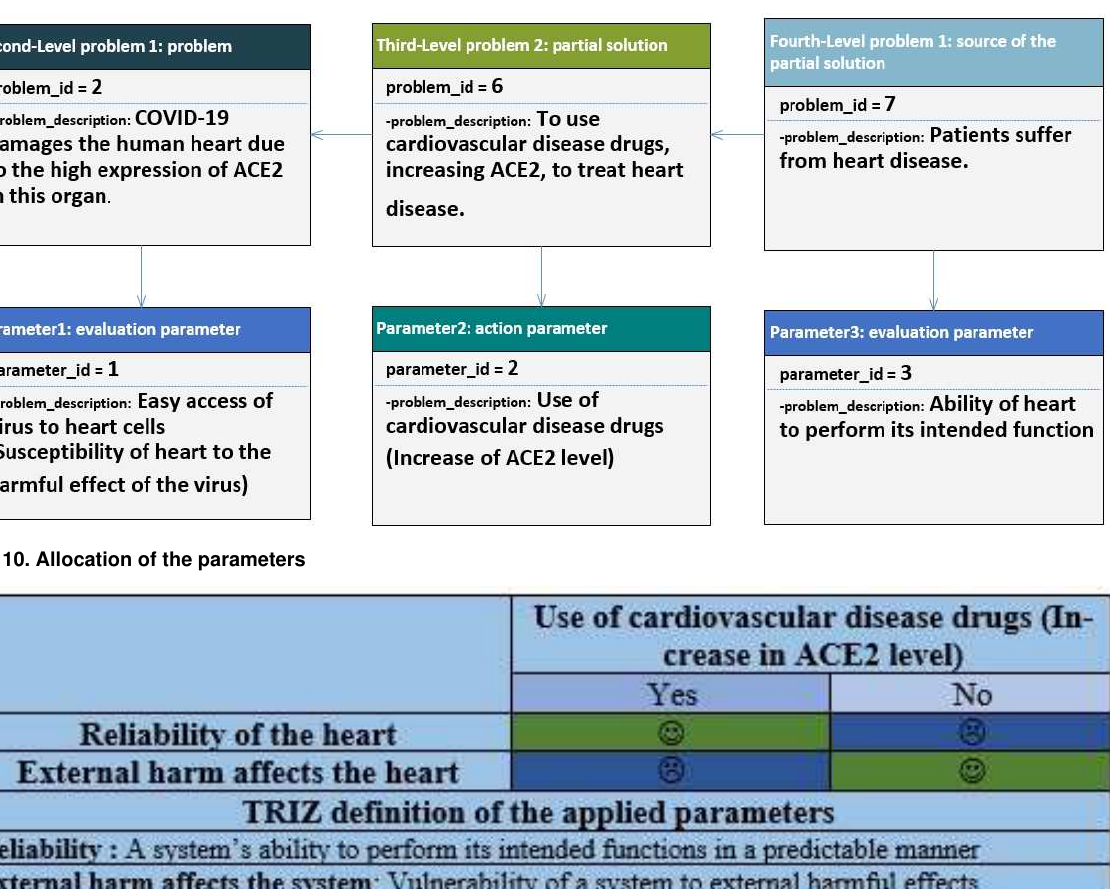
Figure 11. Poly-contradiction model of the TRIZ parameters in relation to the assigned parameters of step 7 of the